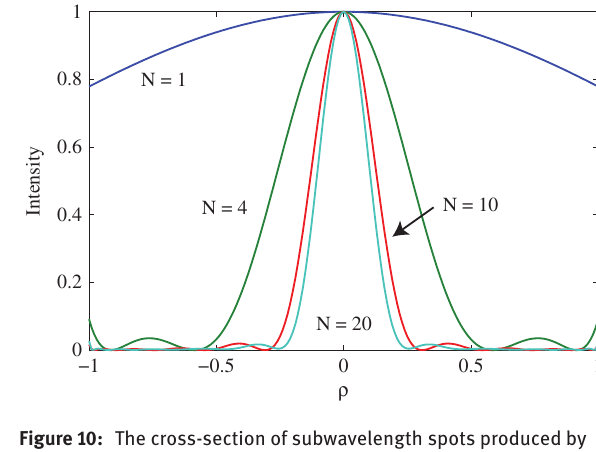
Figure 10: The cross-section of subwavelength spots produced by the optical eigenmode method for sets of LG modes. All spots are circular, and the peaks have been normalized to unity for